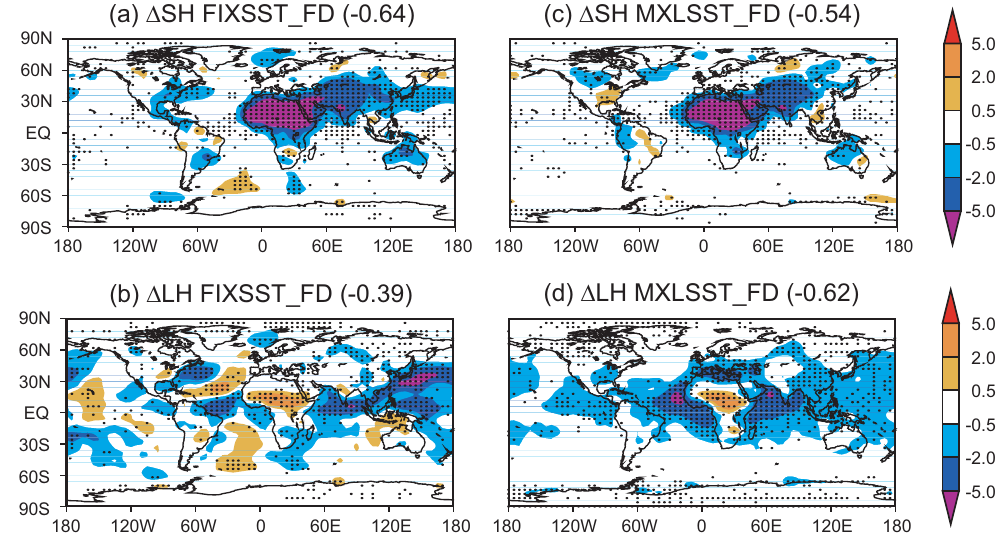
Fig. 5. Simulated dust-induced changes in annual mean sensible heat flux (Wm − 2 , top row) and latent heat flux (Wm − 2 , bottom row). Left panels: Dust-induced changes in heat fluxes with fixed dust density and fixed SST (FIXSST FD - FIXSST CTRL). Right panels: Dust-induced changes with the mixed-layer ocean and fixed dust density (MXLSST FD – MXLSST CTRL). The global mean values are shown in the brackets. Differences that pass the 95% significance level are denoted with dots.